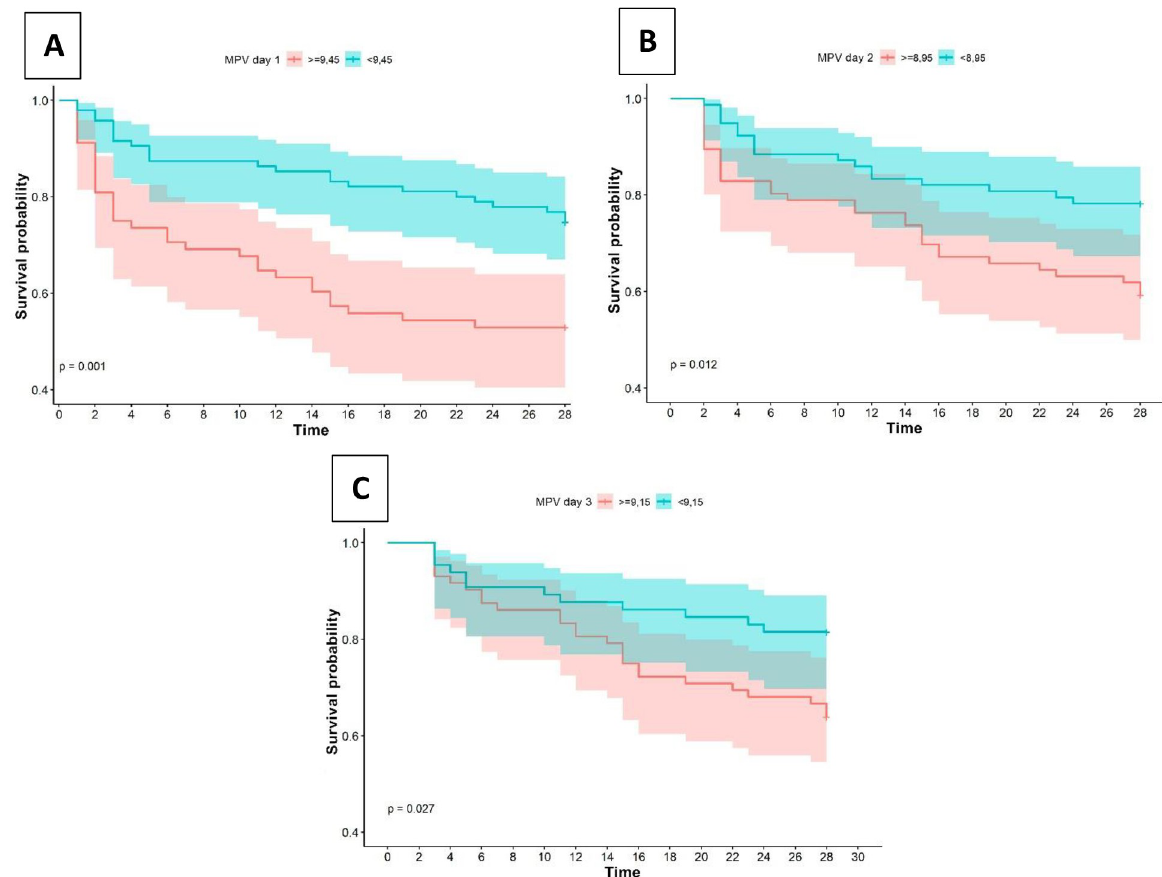
Fig 5. Cumulative survival curve of septic patients by MPV cut-off at day 1 (A); 2 (B); 3 (C).